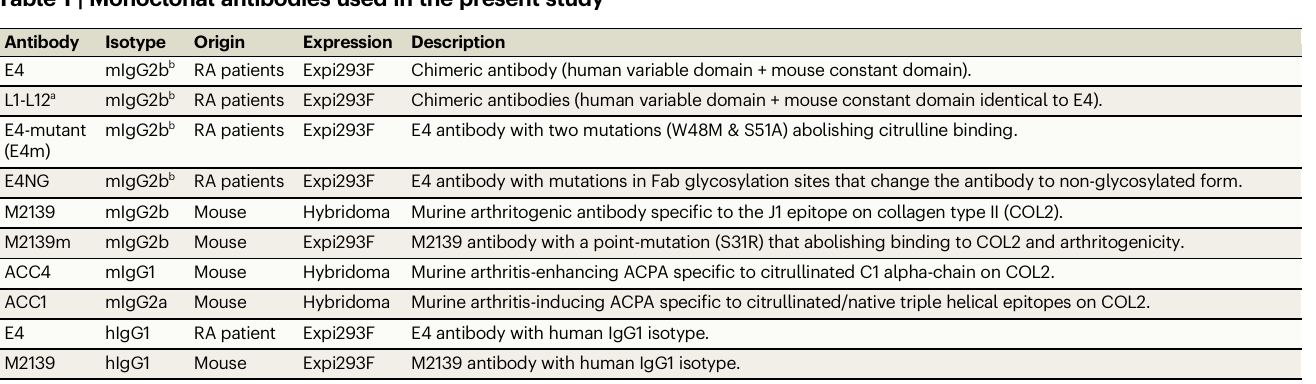
Table 1 | Monoclonal antibodies used in the present study